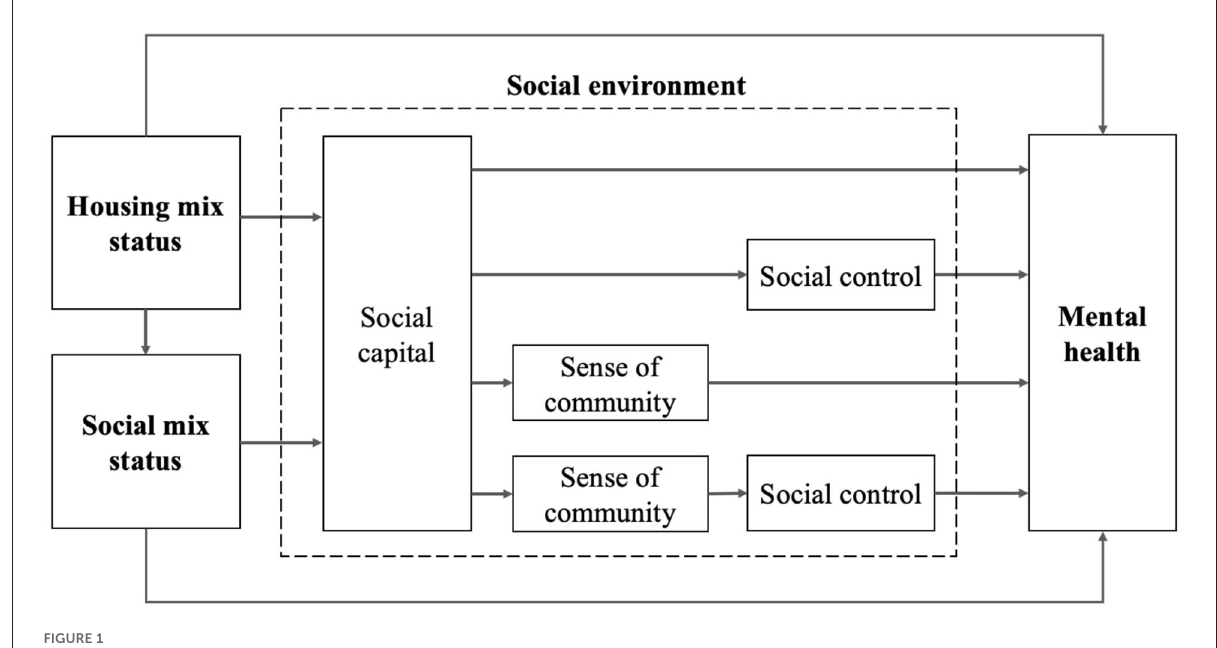
FIGURE1 The conceptual